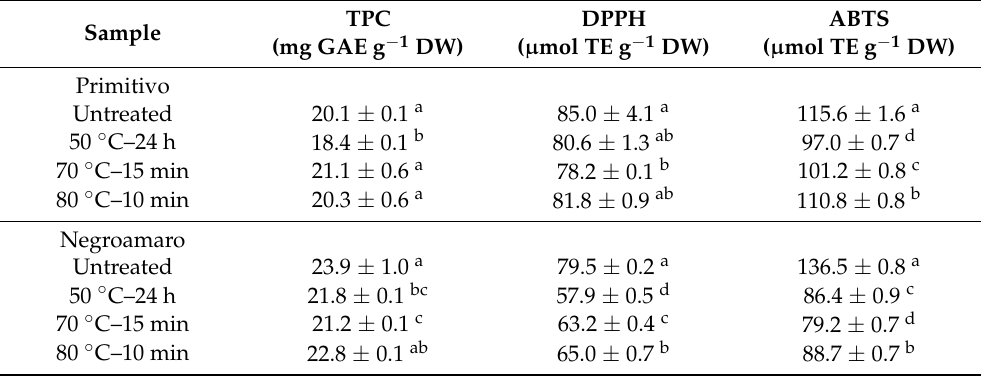
Table 2. The TPC (total phenolic content), DPPH (antioxidant activity determined by the DPPH assay), and ABTS (antioxidant activity determined by the ABTS assay) of the vine shoot extracts from the Primitivo and Negroamaro varieties. Results are expressed as mean ± standard deviation ( n = 2); different letters for each variety in the same column indicate a significant difference according to the Fisher test ( p <